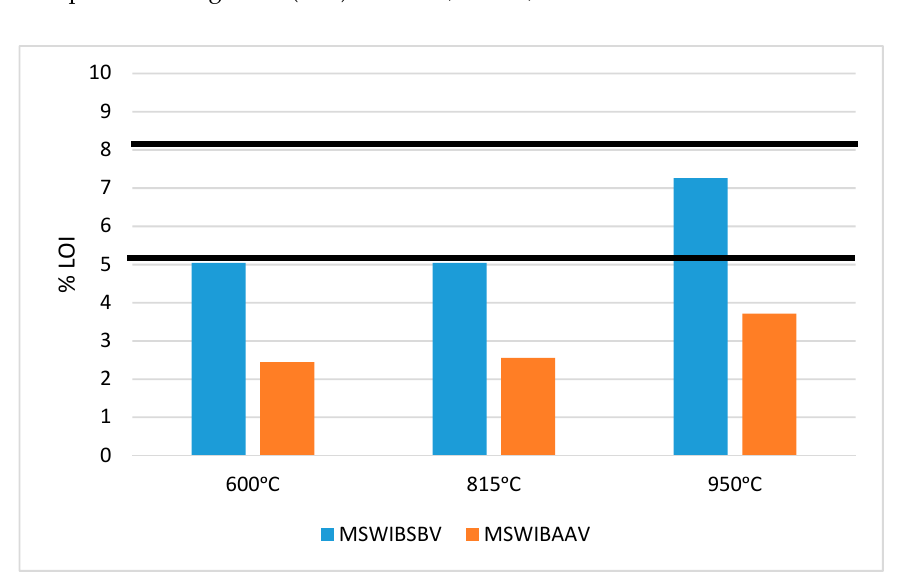
Table 7. Requirements for the chemical composition of the waste [32].